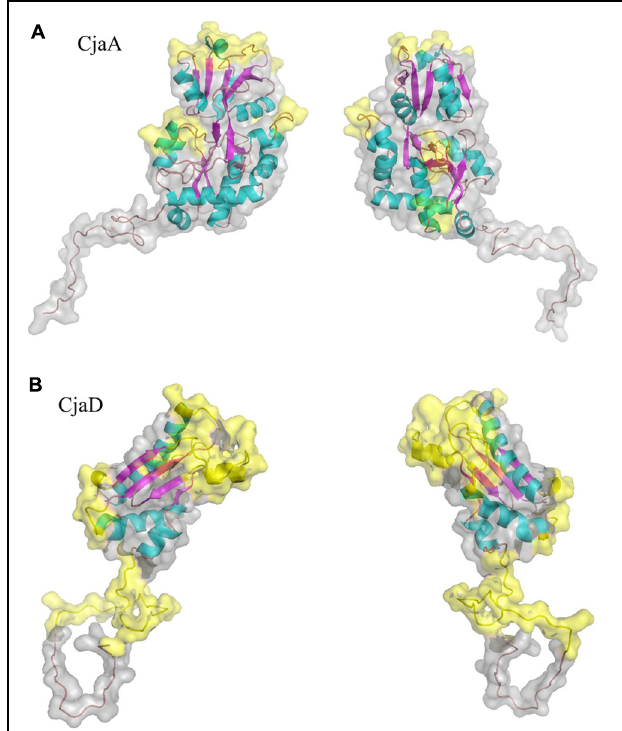
FIGURE 1 | Ribbon and surface diagram of the full-length protein model (A) CjaA, (B) CjaD. Potential peptide epitopes are shown in